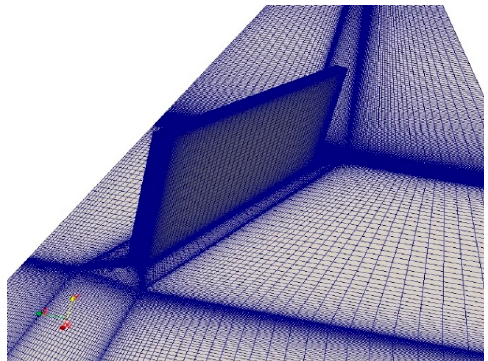
Figure 4. View of the meshing around the rectangular VG.